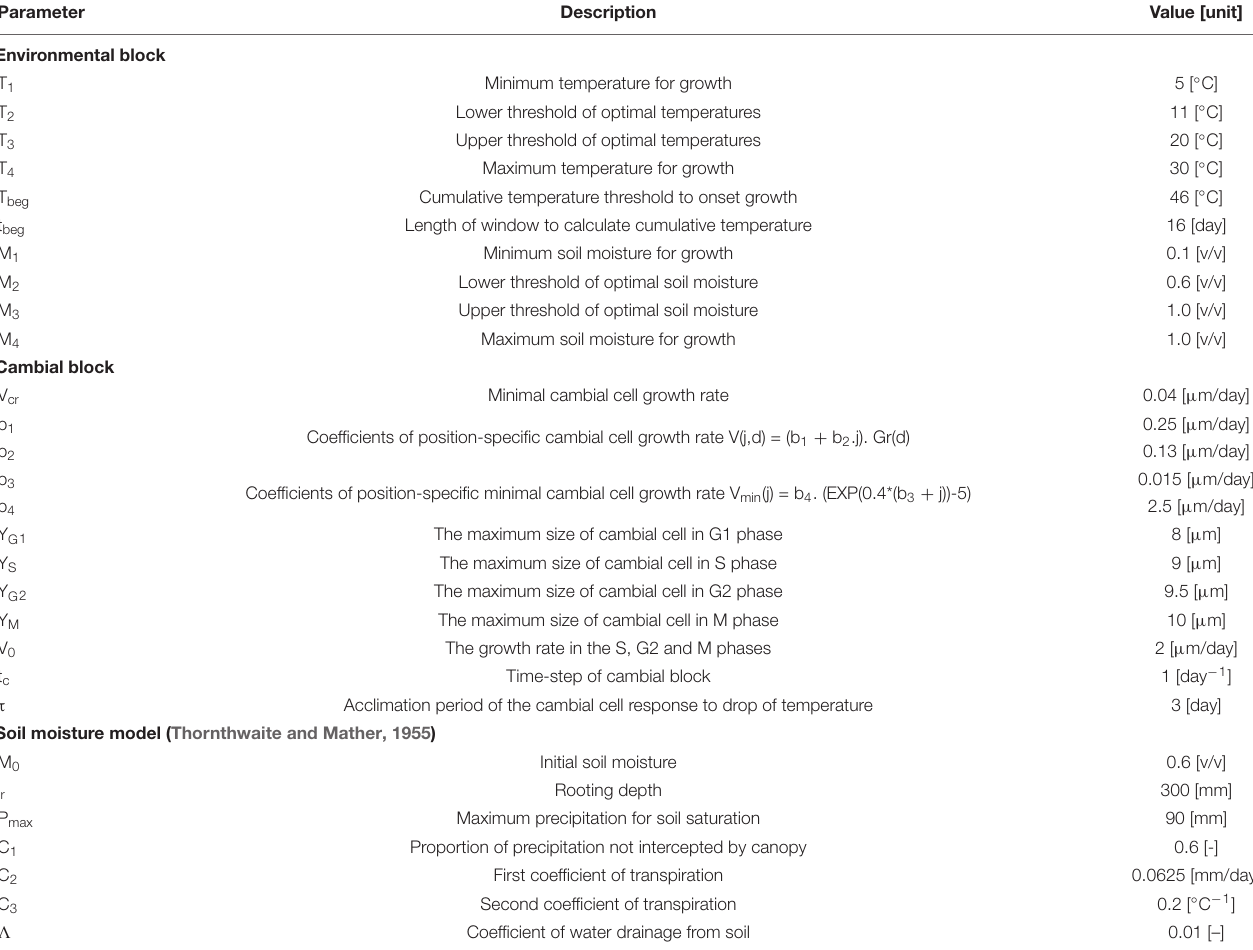
TABLE 1 | List of VS-model parameters. Parameter